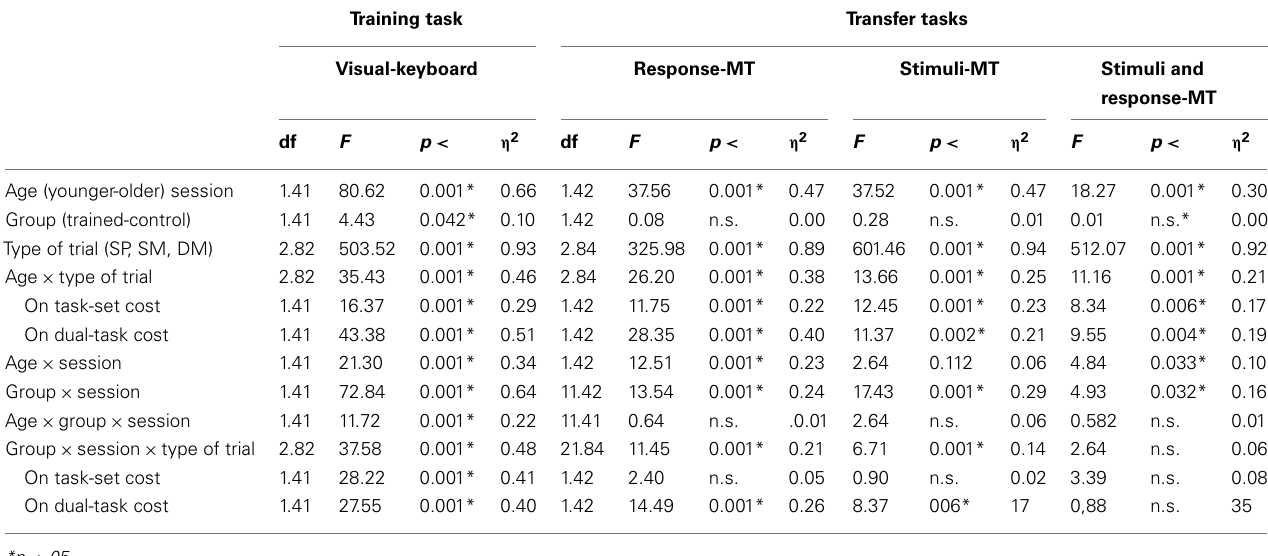
Table 4 | Results of the analyses of variance performed on reaction time for the training and transfer conditions used in the pre-training and post-training sessions.